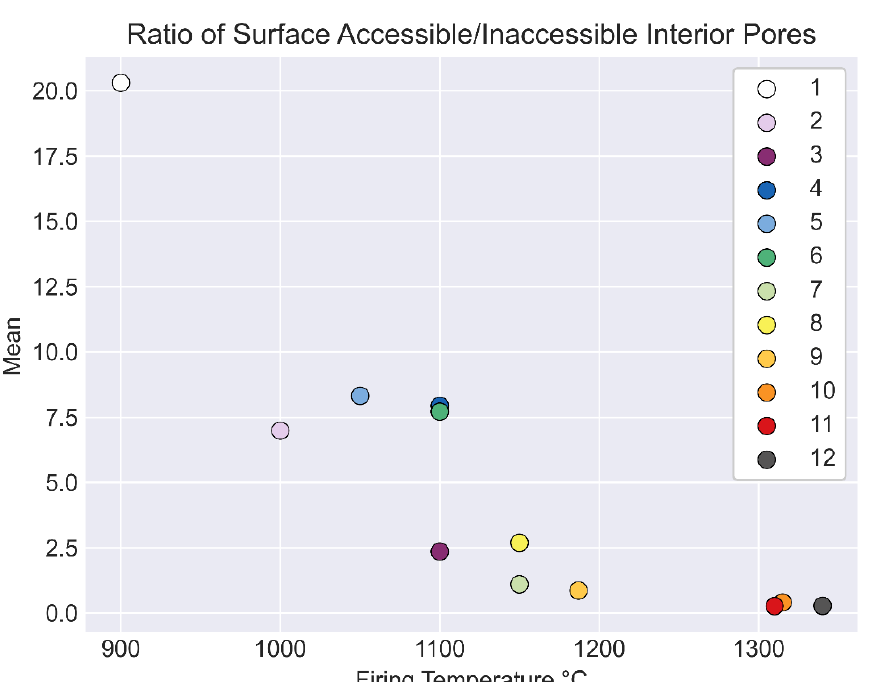
Figure 7. A sample from ceramic 2 ( left ) (13.9 vol.% pores, 12.2% accessible to a surface) has a sur- face/interior pores ratio of 7.1. In contrast, a sample from ceramic 11 ( right ) (1.3 vol.% pores, 0.2% surface-accessible) has a surface/interior pores ratio of 0.2. Pores accessible to a surface are shown in blue, and interior-only pores are in red. Table 3 shows that replication is important since samples taken from different areas of a sherd vary. No ethnographic or archaeological sherds are perfectly homogeneous.